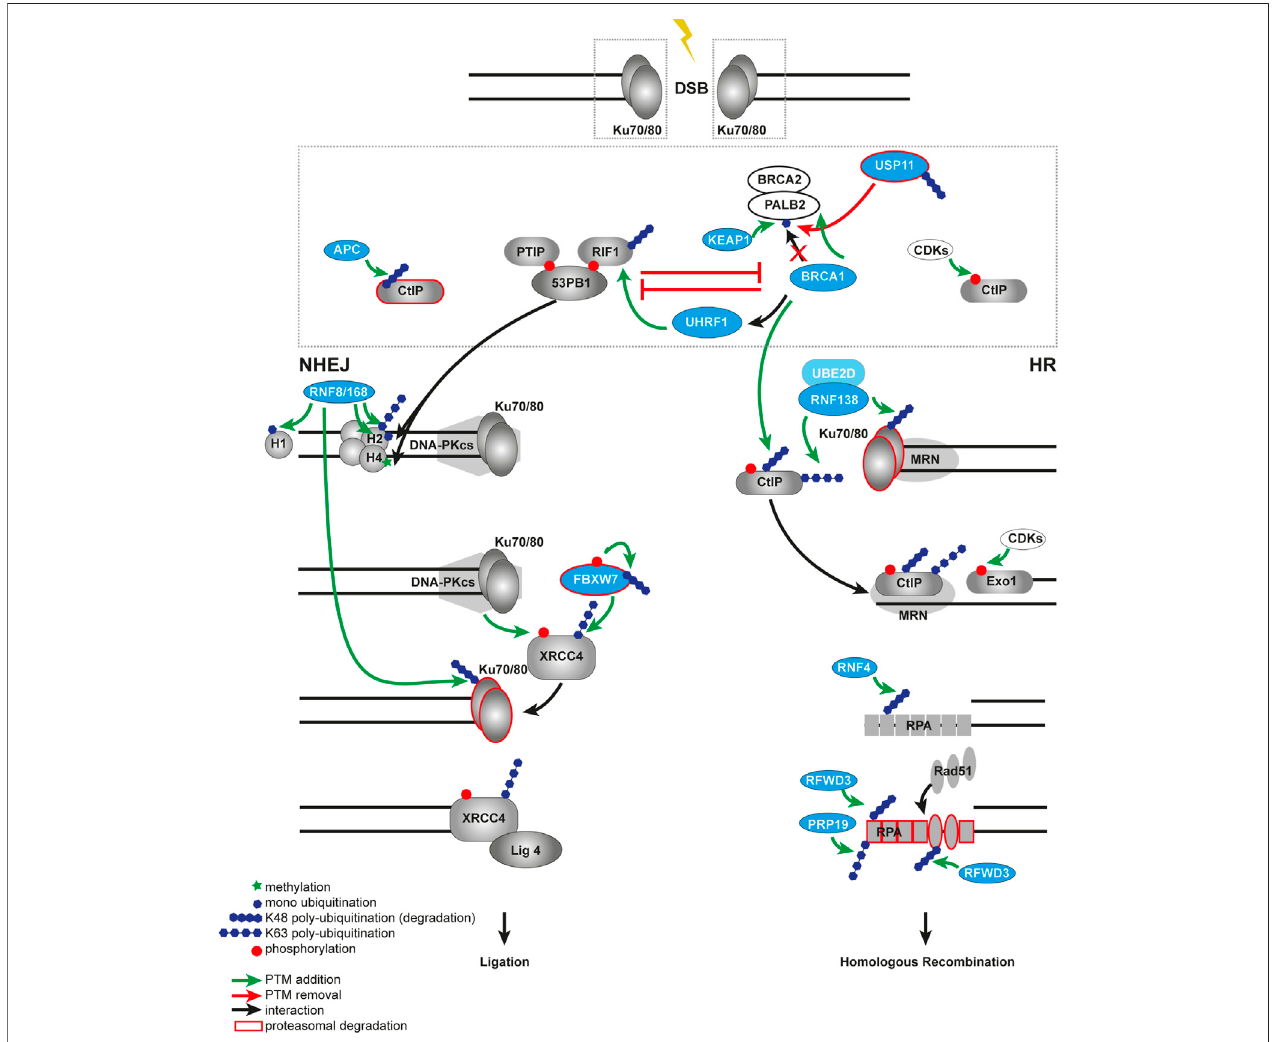
FIGURE3 | Ubiquitination in DSB repair pathway choice. Open DNA ends are rapidly recognized bythe Ku70/80 heterodimer. The choice between NHEJand HR at the DSB is controlled by the competition between 53BP1 and BRCA1. In a NHEJ-permissive environment, 53BP1 builds a complex via ATM in a phosphorylation- dependentmannerwithitsbindingpartnersRIF1andPTIP.The53BP1-PTIP-RIF1complexpreventsrecruitmentofBRCA1tothebreakand,therefore,antagonizesHR. The E3 ubiquitin ligase KEAP1 ubiquitinates PALB2 at the BRCA1 binding site and prevents assembling of the BRCA1-BRCA2-PALB2 complex, thus, promoting NHEJ. This process is balanced by the DUB USP11 and controlled by the cell cycle. BRCA1 antagonizes NHEJ by impairing retention of RIF1 at DSB sites in a CtIP- or UHRF1-dependent manner. Ubiquitin-dependent degradation ofCtIP bythe APC/C inNHEJ prevents resection process, in contrast toHR,whereCtIP isnotdegraded but phosphorylated by the CDKs. The RNF8-RNF168-mediated ubiquitination on chromatin provides a binding platform for both 53BP1 and BRCA1. Later RNF8 also ubiquitinates Ku70/80 to facilitate its proteasomal degradation and removal from the broken DNA ends.In a HR-permissive environment the E3ubiquitin ligase RNF138 ubiquitinates Ku to remove it from DSB much earlier compared to NHEJ, allowing end-resection factors to gain access to the deprotected ends. RNF138 also ubiquitinates CtIP, enhancing its retention on damaged chromatin. At the later steps of NHEJ the ligation of broken ends promoted by FBXW7 that recognizes phosphorylated XRRC4 and subsequently ubiquitinates it. In contrast during the later steps of HR, RPA SUMOylation-guided ubiquitination by RNF4 promotes RPA turnover and RAD51 recruitment. Multi-site ubiquitination of RPA by the ubiquitin ligases RFWD3 and PRP19 also facilitates HR.